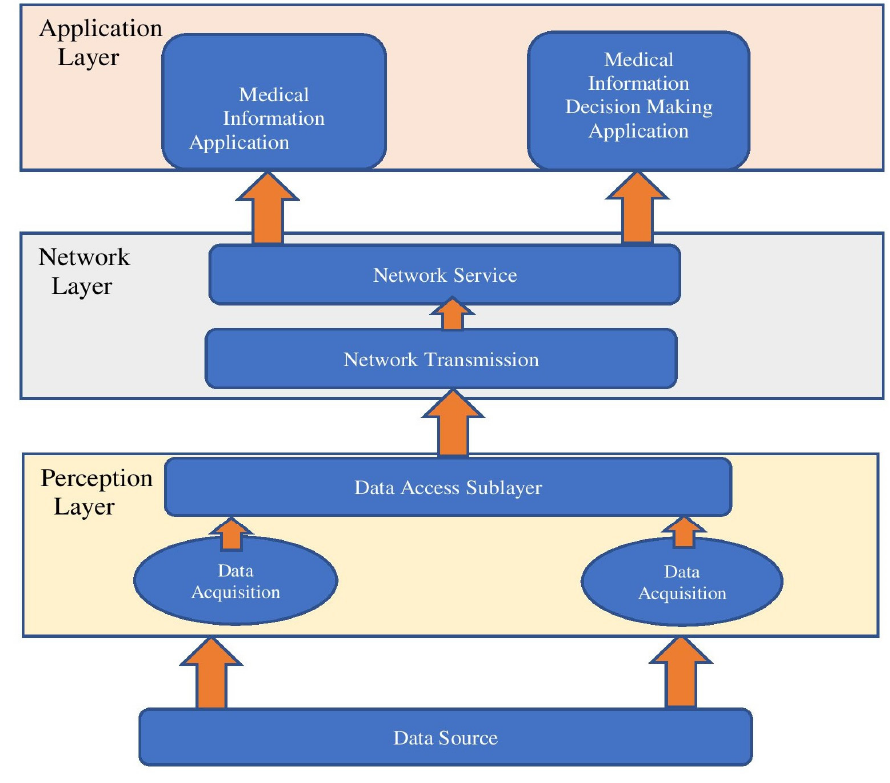
Figure 4. IoMT architecture [49].